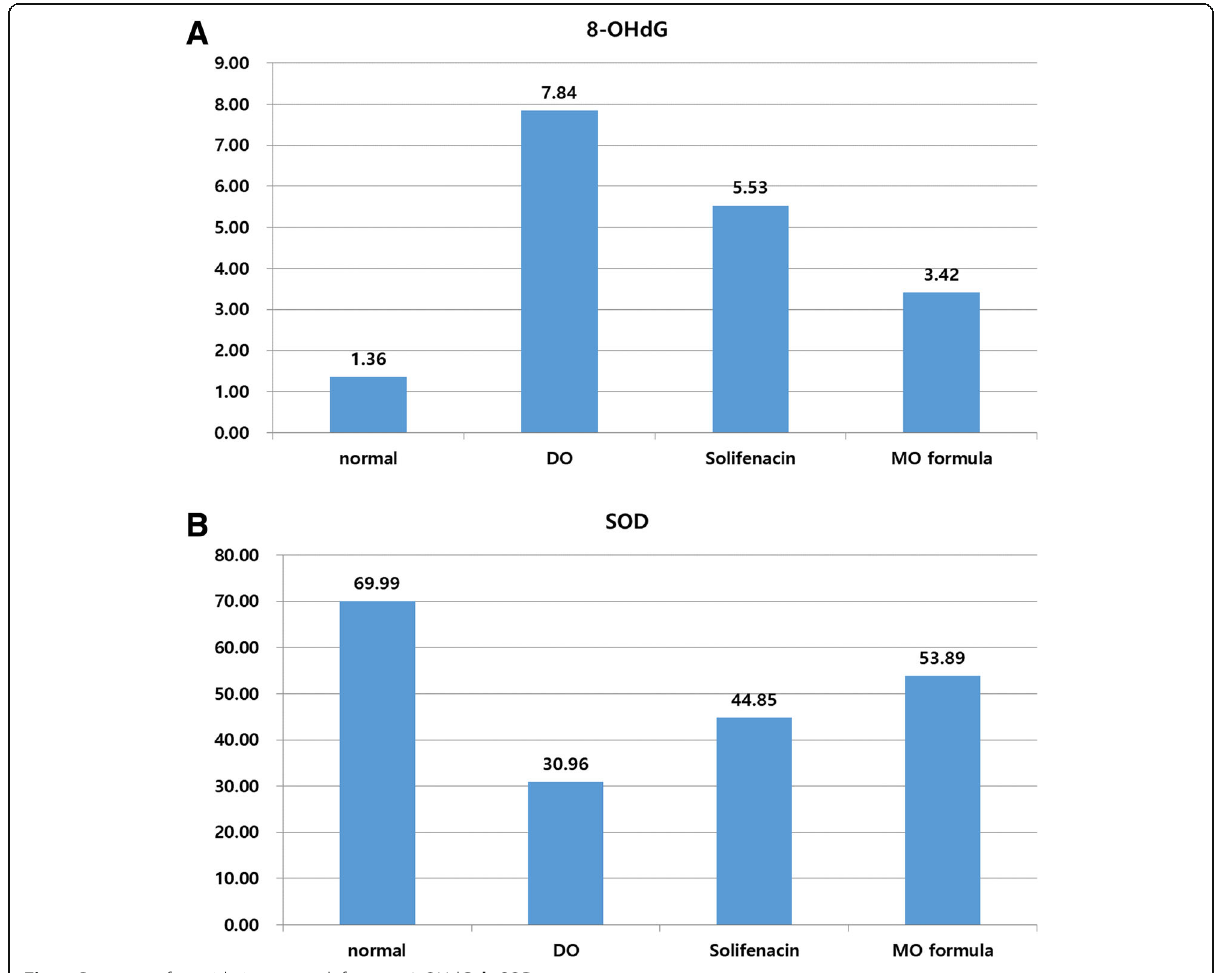
Fig. 5 Parameter for oxidative stress defense. a 8-OHdG. b SOD